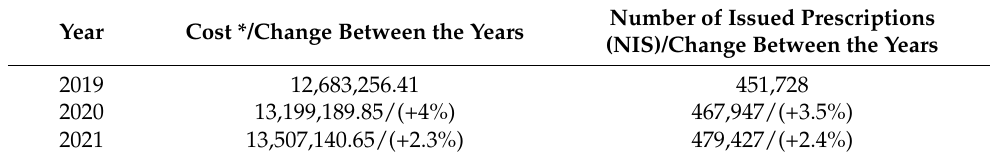
Table 1. National medication consumption in dental medicine between 2019 and 2021.